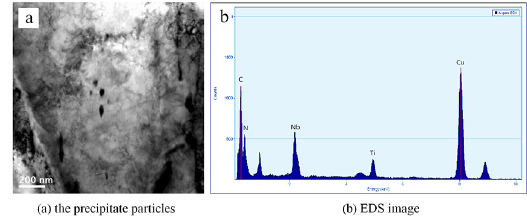
Figure 10. TEM micrograph of specimen A-5 showing the presence of carbonitrides precipitates.